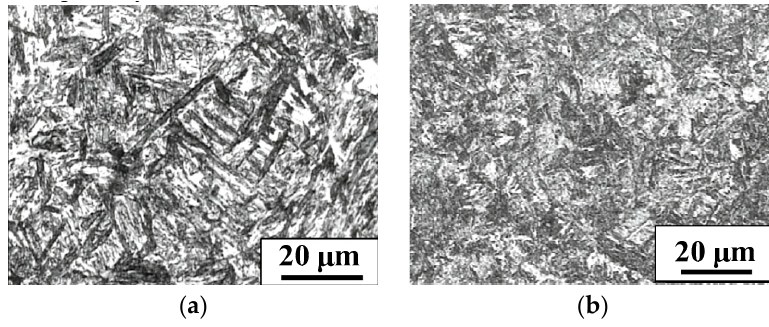
Figure 2. Microstructure metallograph of screw specimen after ( a ) quenching and ( b ) quenching and tempering.